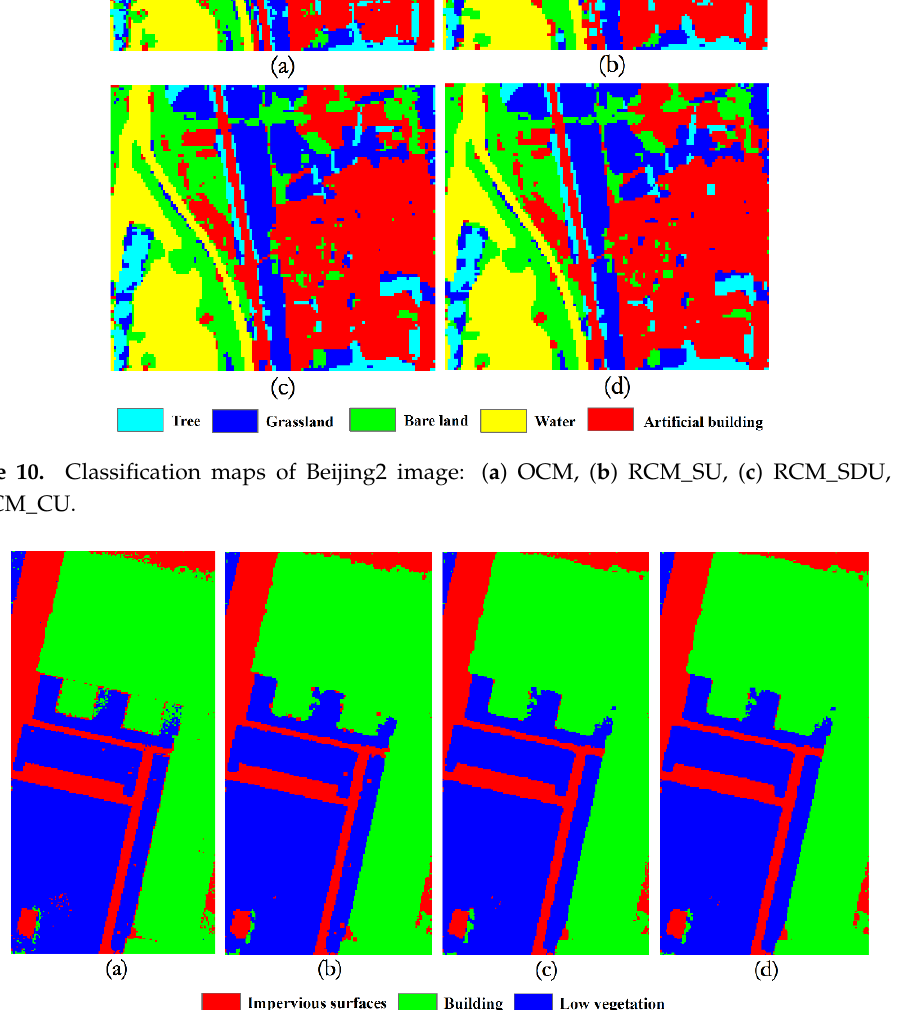
Figure 11. Classification maps of Potsdam image: ( a ) OCM, ( b ) RCM_SU, ( c ) RCM_SDU, and ( d ) RCM_CU.